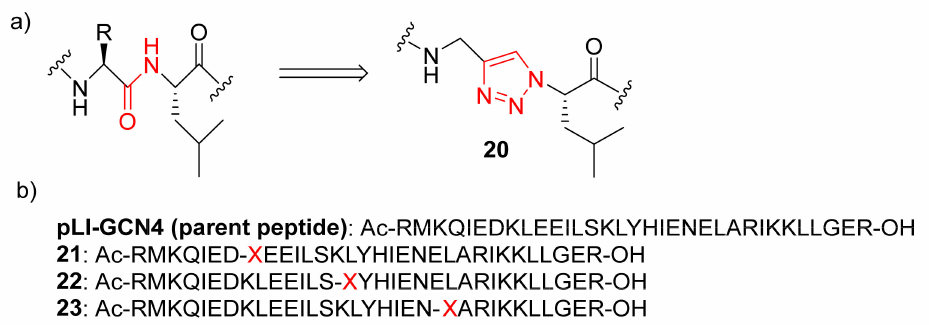
Figure 10. ( a ) Exchange of the dipeptide fragment with the triazole dipeptide mimetic; ( b ) re- placement of the native amino acids, pLI-GCN4 K 8 L 9 ( 21 ), K 15 L 16 ( 22 ), and E 22 L 23 ( 23 ), with the peptidomimetic 20